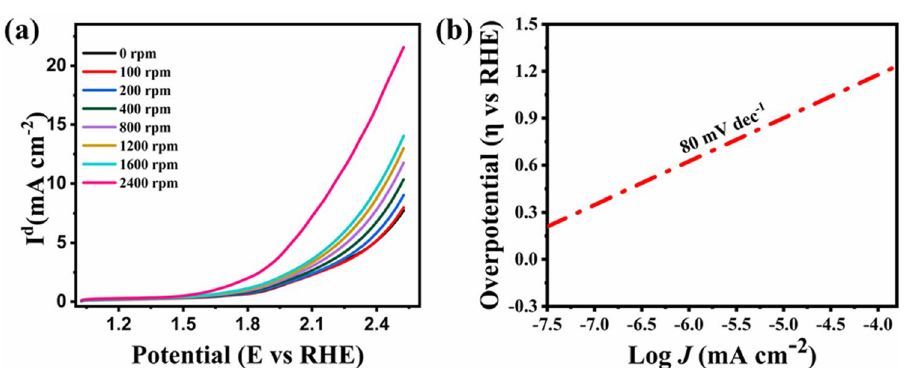
Figure 5. Electrochemical investigation of OER in 1 M KOH solution (N 2 saturated) ( a ) LSV graphs of CCTO at different rotations between the potentials of 0.0–2.4 V ( b